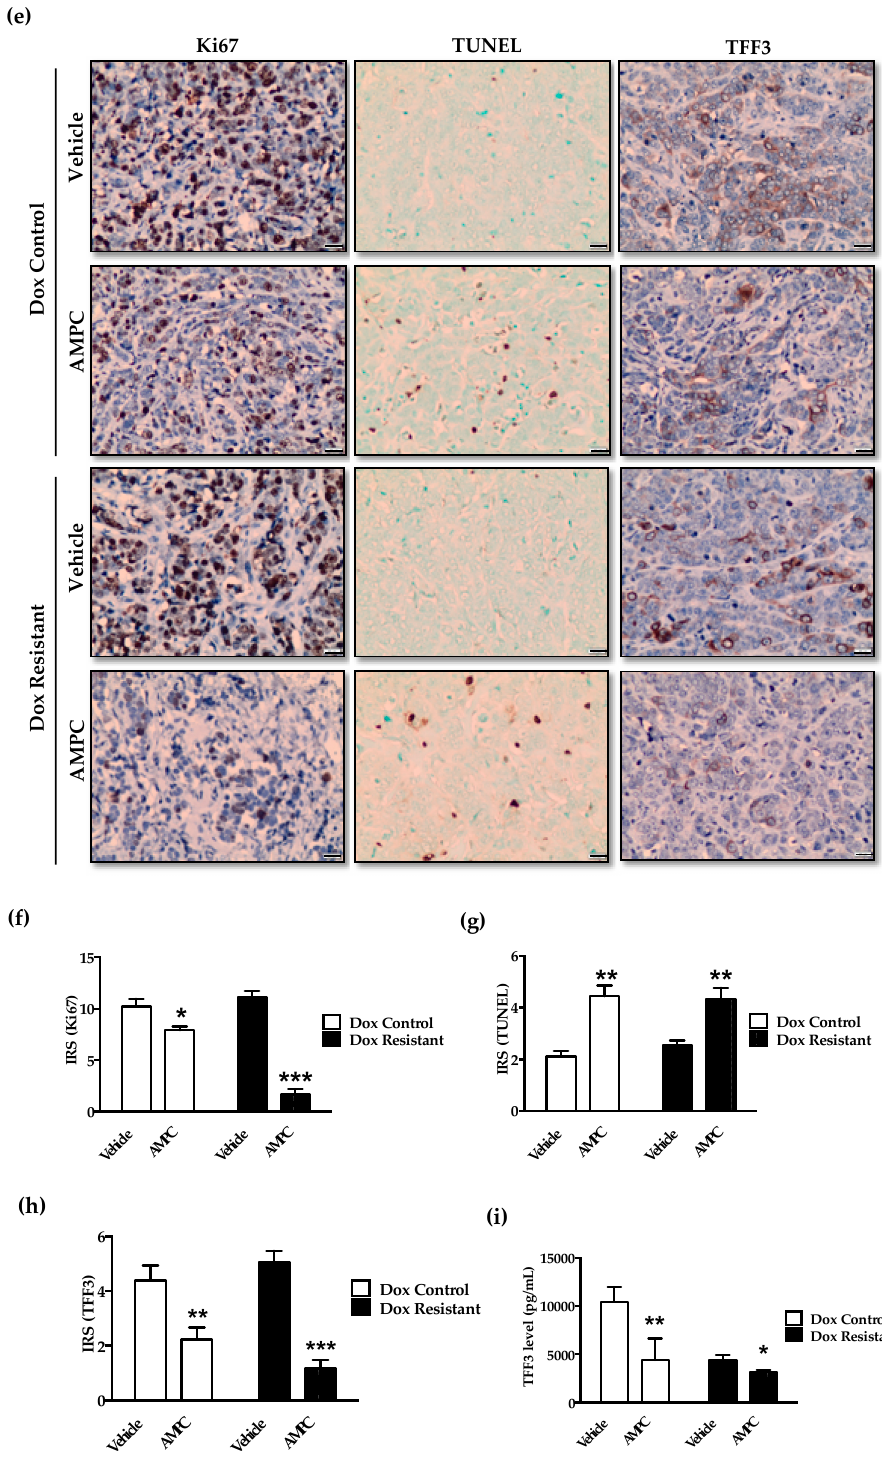
Figure 7. Inhibition of TFF3 by AMPC inhibits the in vivo growth of ER + MC xenografts. Doxorubicin control and resistant ER + MCF-7 cells were injected orthotopically into the mammary fat pad of nude mice. ( a ) Tumour volumes and ( b ) % change in tumour volume in mice were recorded daily with vehicle or AMPC treatment over 15 days. ( c ) Representative photographs of tumour sites (left) and the corresponding micrographs of the H&E-stained tumour sections at 200 × magnification (right). ( d ) Representative photographs of tumours from each treatment groups and the average tumour weights. (e–h) Immunohistochemistry (IHC) staining was performed on tumours for Ki67, TUNEL and TFF3. Representative micrographs were taken at 200x magnification and staining intensity were scored